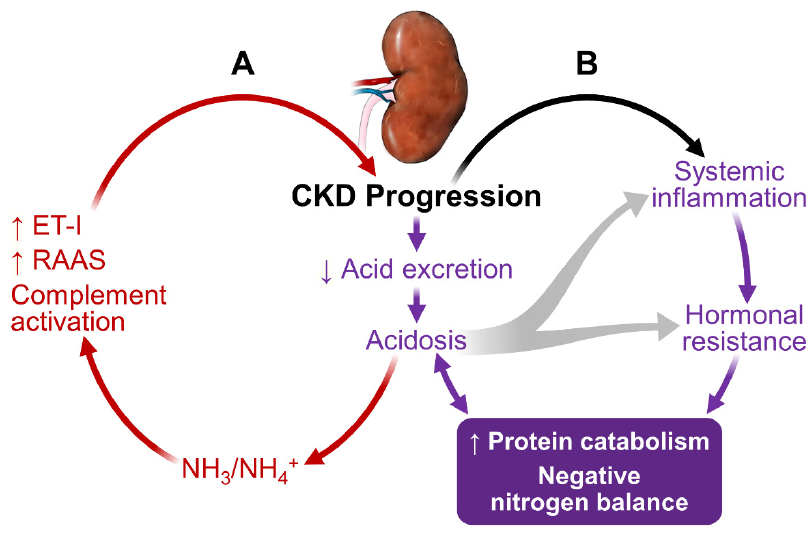
Figure 1. Interconnection of CKD progression with metabolic acidosis, inflammation, hormonal resistance and protein catabolism. ( A ) Kidney dysfunction limits proton (H + ) excretion, resulting in a systemic metabolic acidosis. The acidosis causes activation of complement systems, renin angiotensin aldosterone systems and endothelin ‐ 1. These acidosis ‐ mediated effects cause CKD progression, forming a viscous cycle; ( B ) Acidosis promotes inflammation and tissue resistance to multiple anabolic hormones and simultaneously enhances activity of catabolic corticosteroids. Protein catabolism generates acidic products, contributing to acidosis in the setting of CKD and ESRD. Collectively, these abnormalities give rise to a state of protein catabolism, causing sustained negative nitrogen balance, leading to muscle wasting.